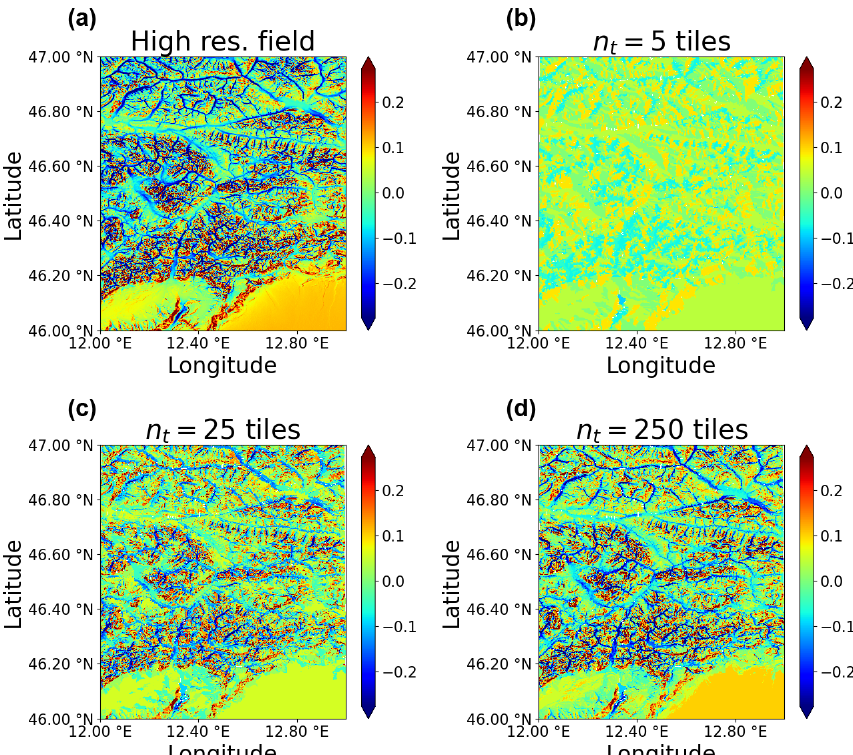
Figure 11. Normalized differences between 3D and PP diffuse fluxes for high-resolution predictions (a) and predictions for different numbers of tiles (5, 25, 250) in panels (b, c, d) . The sub-grid tile structure was obtained here by keeping constant the number of characteristic hillslopes ( k ), while varying the number of clusters in each hillslope ( p